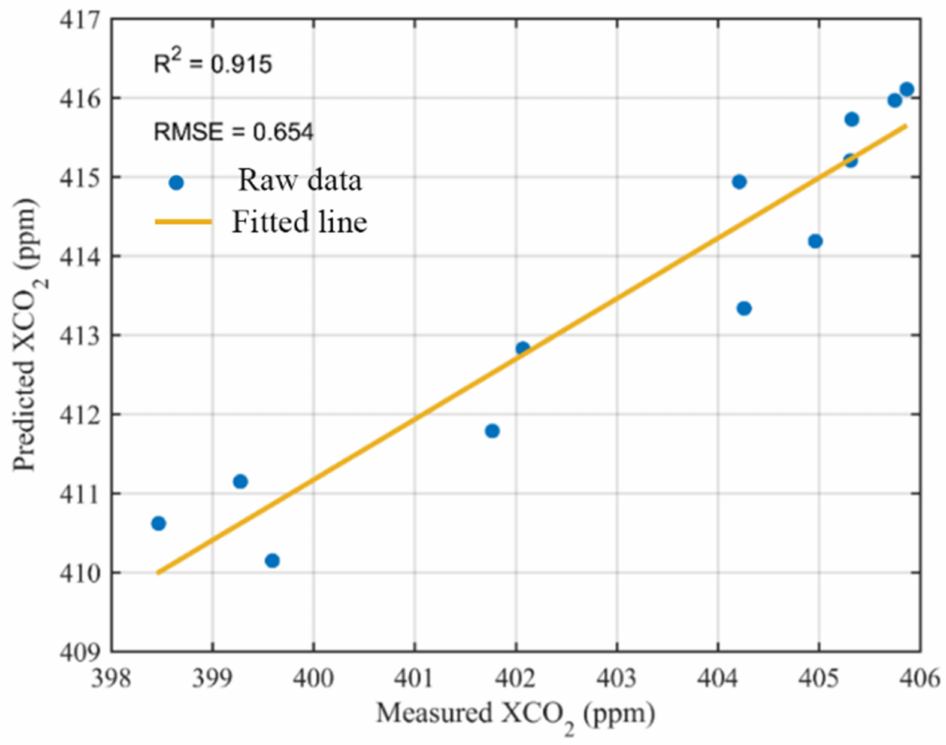
Figure 3. Verification results of the CO 2 interpolation and TCCON data. The yellow line represents the results of the local weighted regression, the measured and predicted XCO 2 represents the observed TCCON data and interpolated data,